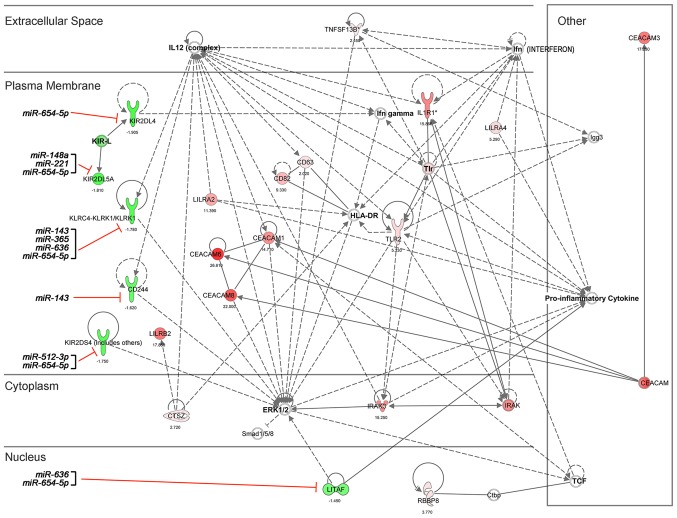
Ingenuity Pathway Analysis (IPA) Core Analysis-based network of microRNA (miRNA)-mRNA interactions in peripheral blood NK (pNK) cells during pregnancy. The network displays interactions between natural killer (NK) cell function-associated genes that were differentially expressed between first- and third-trimester pNK cells; the network was filtered by NK cell context with a minimum of ten genes per category. Genes upregulated in third- relative to first-trimester pNK cells are indicated in shades of red; genes downregulated in third-trimester pNK cells are indicated in shades of green; genes in white circles were not in our data set but were inserted by IPA because they are connected to this network. Numbers below symbols represent the fold changes in transcript level of third- relative to first-trimester pNK cells. Solid and dashed lines indicate direct and indirect interactions, respectively. miRNAs that showed an upregulated expression in third- compared to first-trimester pNK cells and had the in silico target sites in the 3′-untranslated region (3′-UTR) of downregulated genes (green) are also shown.